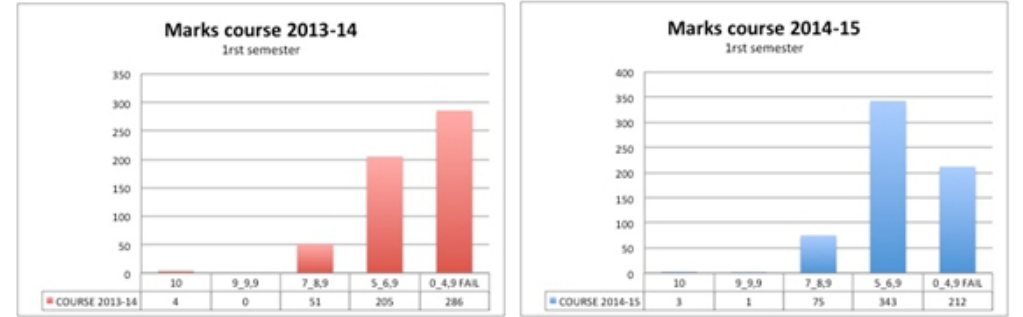
Figure 5. Qualifications course 2013-14 and 2014-15 first